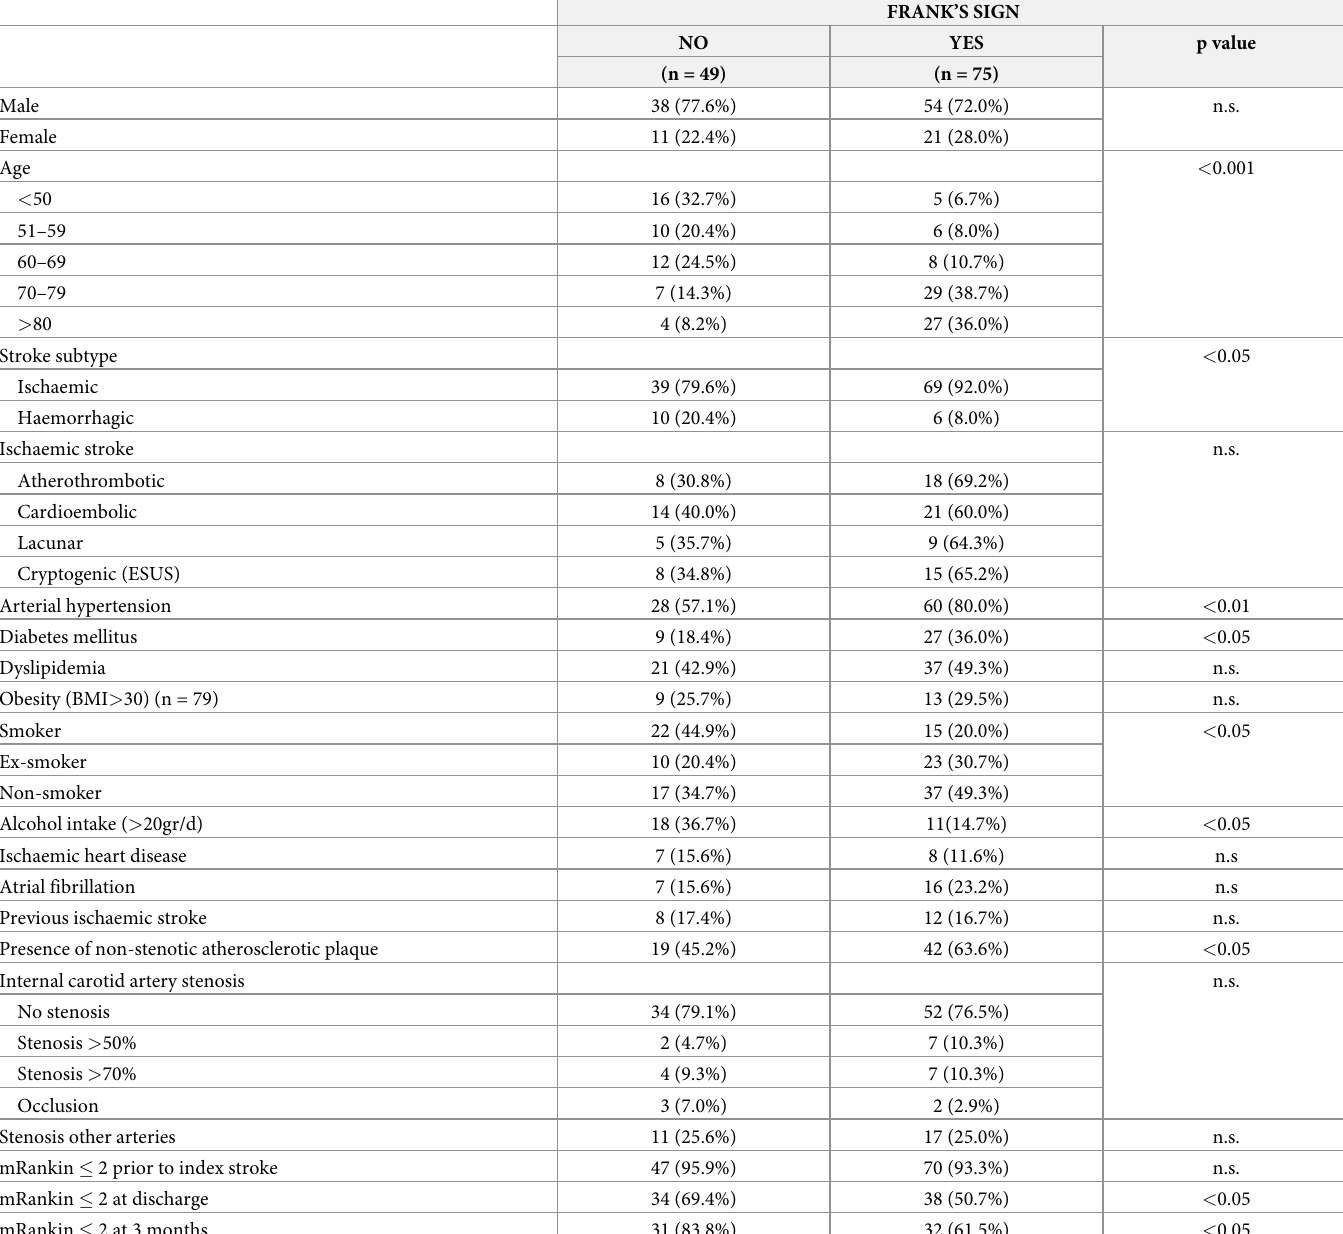
Table 1. Bivariate analysis of the Frank’s sign by clinical variables included in the